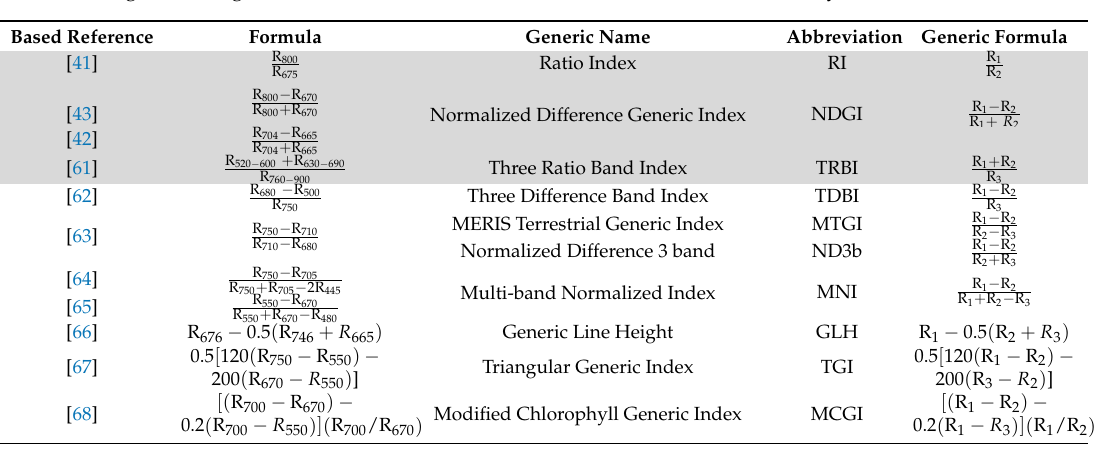
Table 3. Generic vegetation indices introduced in Automated Radiative Transfer Models Operator (ARTMO), where indices based on commonly LAI green indices are shown shaded and typically indices used to estimate other biophysical parameters are shown non-shaded. R λ represents reflectance at the wavelength λ . The generic name of each index has been established in this